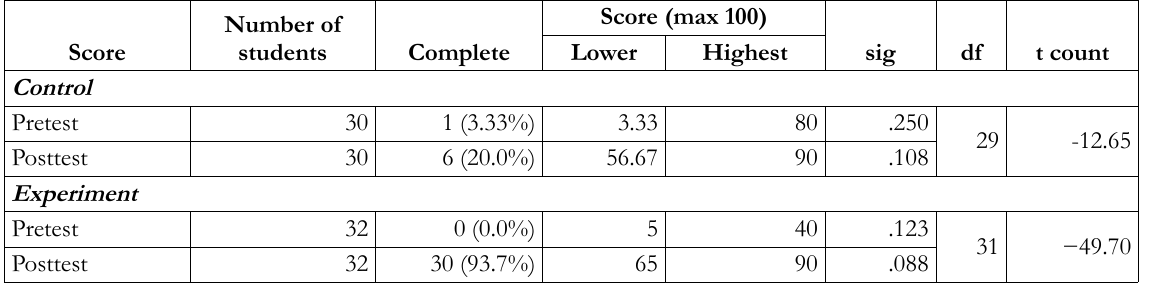
Table 3. Students’ learning outcomes